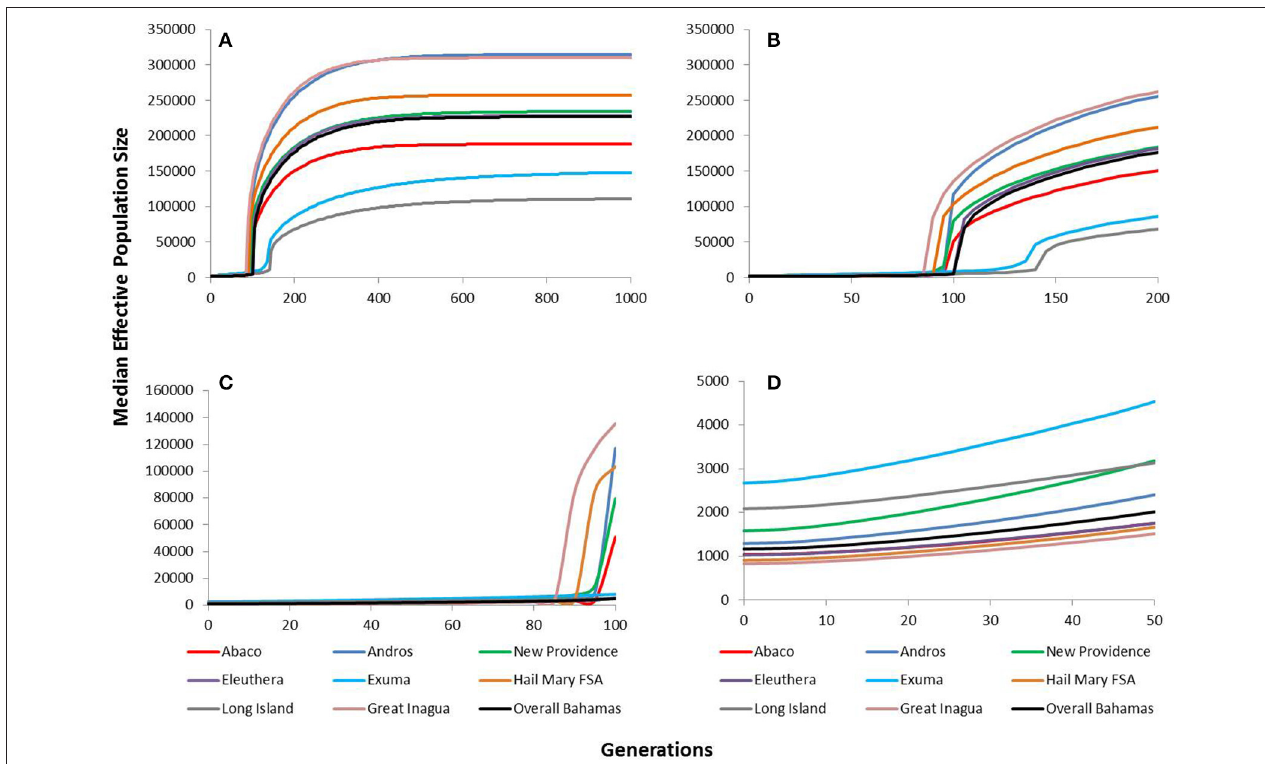
FIGURE 5 | VarEff estimates of temporal changes in the effective population sizes, N e of Nassau grouper from Abaco (red), Andros (blue), New Providence (green), Eleuthera (purple), Exuma (blue), Hail Mary FSA (tan), Long Island (gray), Great Inagua (pink) and overall Bahamas (black) for (A) the past 1,000 generations, (B) the past 200 generations, (C) the past 100 generations, and (D) the past 50